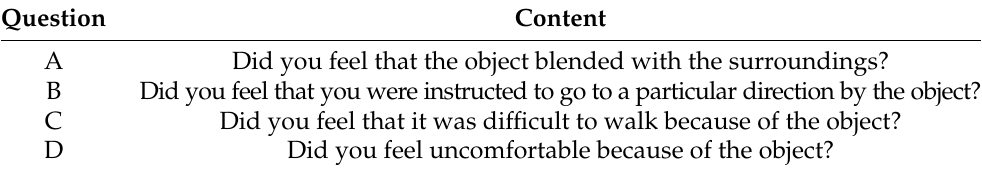
Table 4. The contents of the